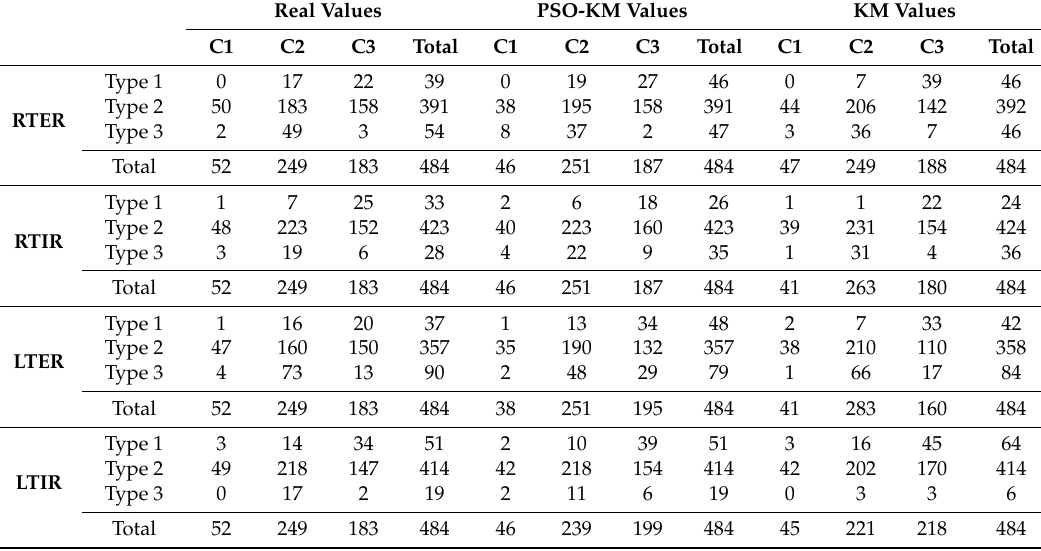
Table 4. Comparison of the results of the PSO-KM algorithm and the results of the KM